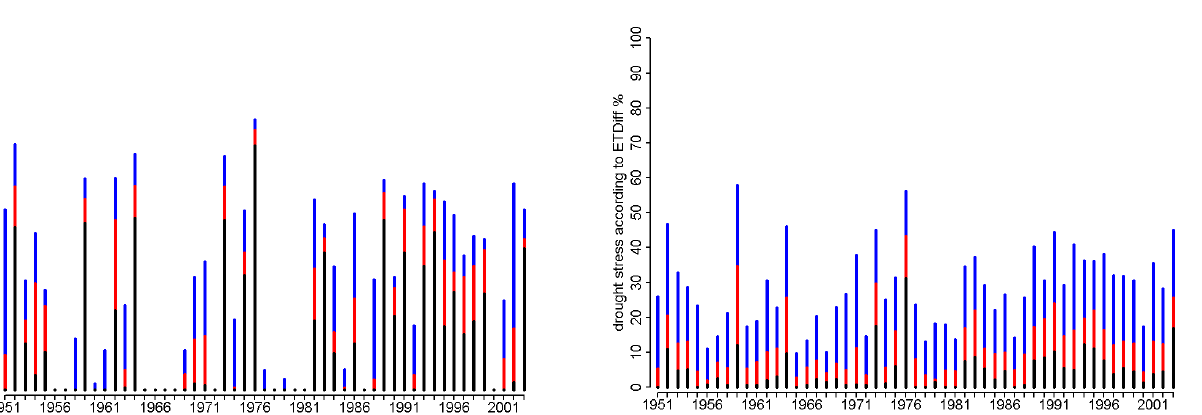
1 Fig. 2. Drought stress index SWT with thresholds of pF=3.5 (blue), pF=3.8 (red) and pF=4 (black) for an even site and an available wa- ter capacity of 150mm; period 1951–2003; climate station “Deusel- bach”, Germany.